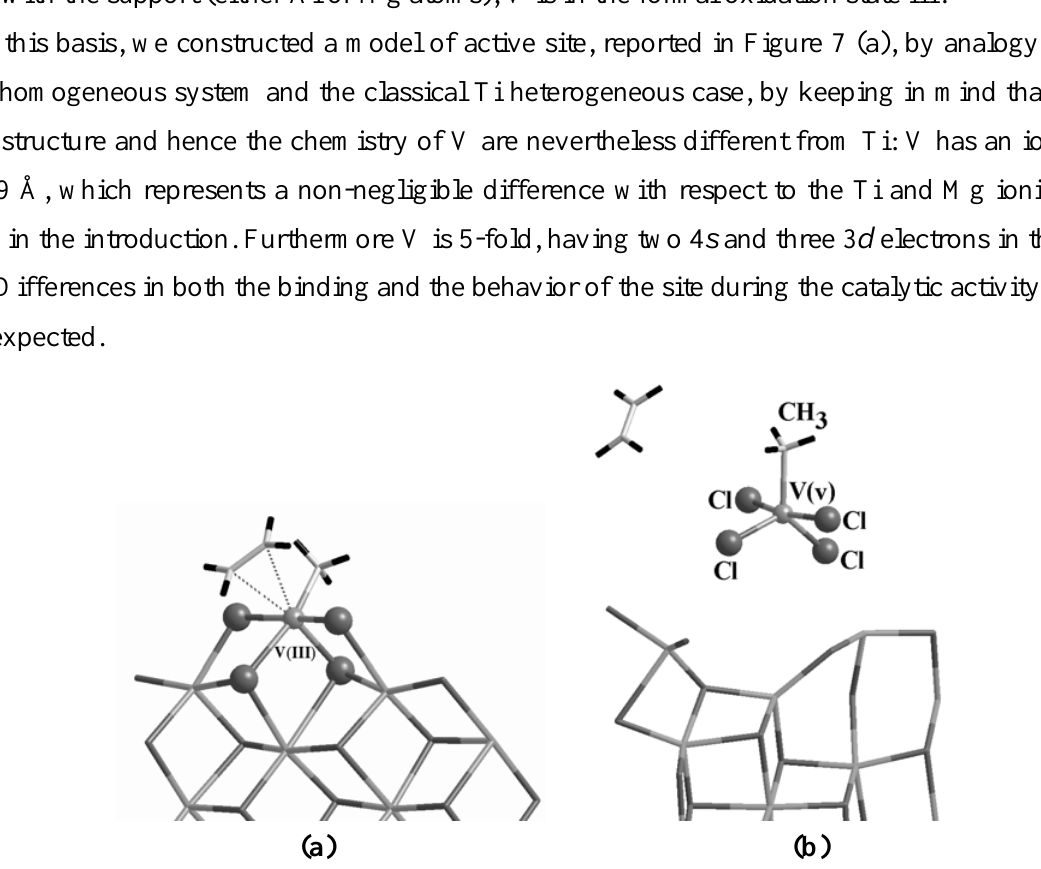
Figure 7. The model for an active V center supported on MgCl homogeneous system of Figure 6. During the dynamics, the complex is destabilized as in (b) and the V reverts to an unbound 5-fold molecule leaving the